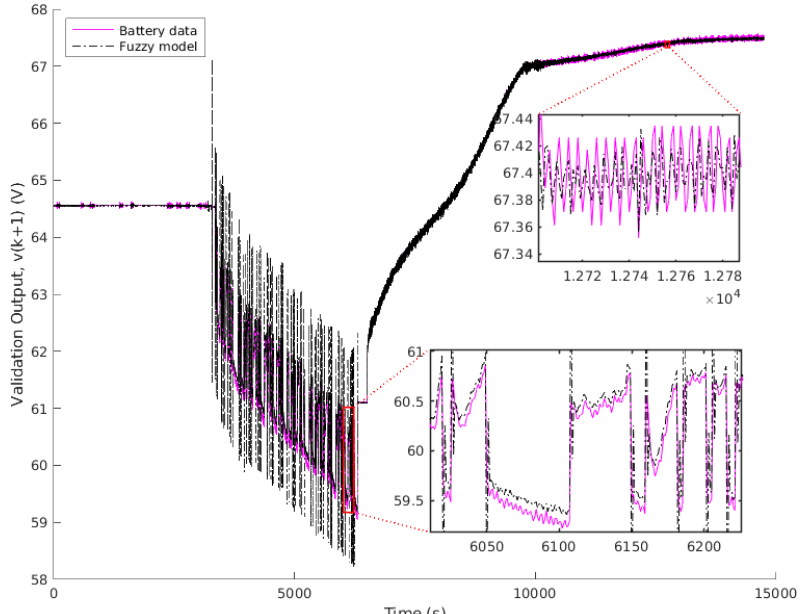
Figure 11. Validation